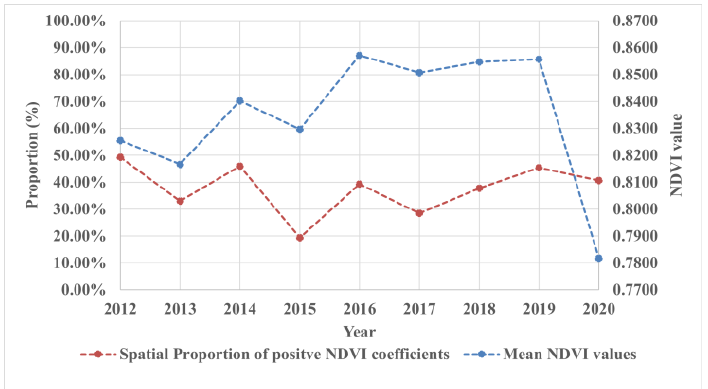
Figure 6. Temporal trends of mean NDVI values and mean NDVI coefficients in ( a ) Xuancheng and ( b ) Ma’anshan .